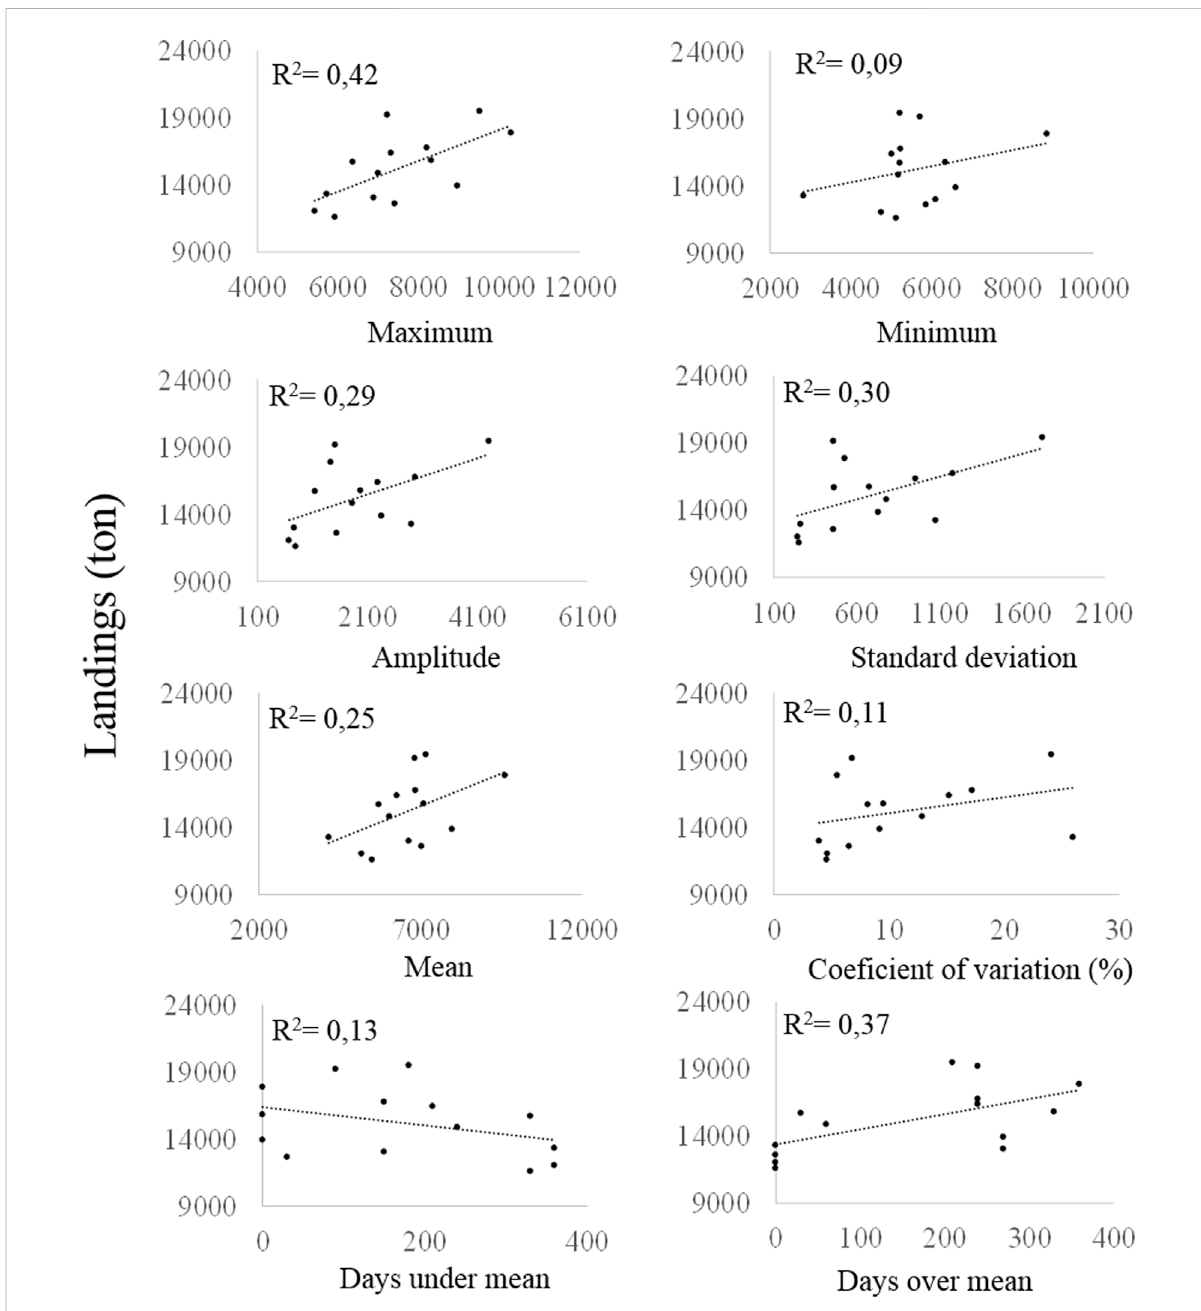
FIGURE 7 Data characteristics of the fl ooded area and fi shery landings (estimated) in the Magdalena River in years 2001 –